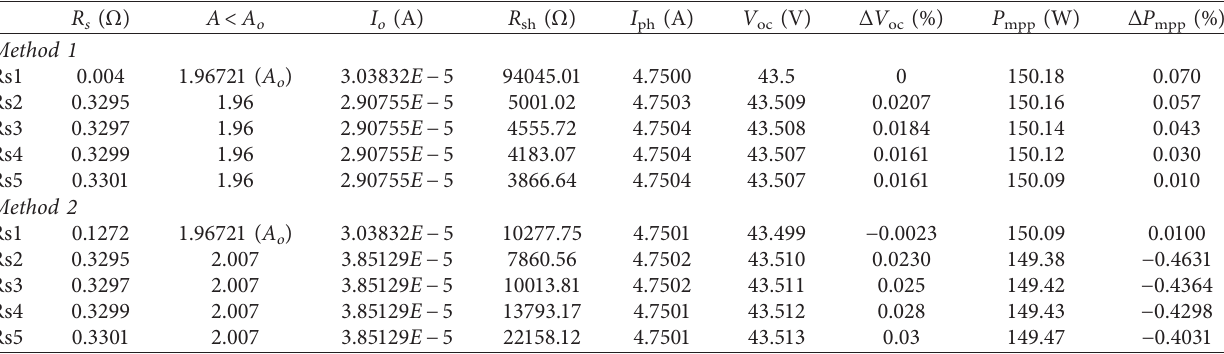
Table 4: Extracted parameters and data from simulations for BP-SX 150.